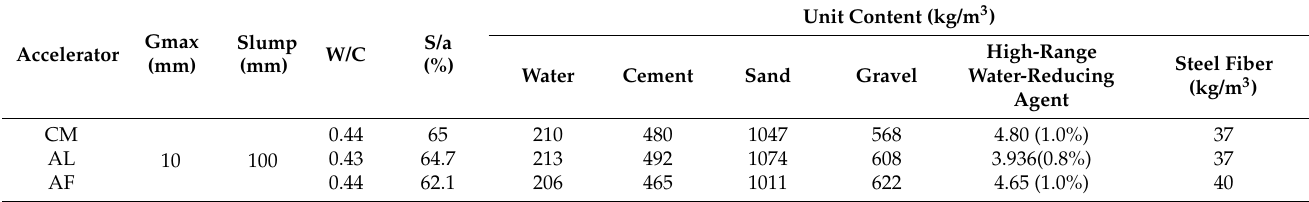
Table 3. Shotcrete performance test mix